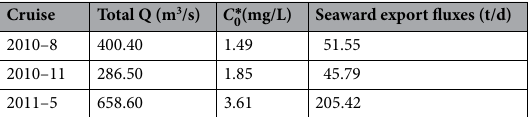
Table 4. Estimated effective concentration and export flux of TOC by cruise.